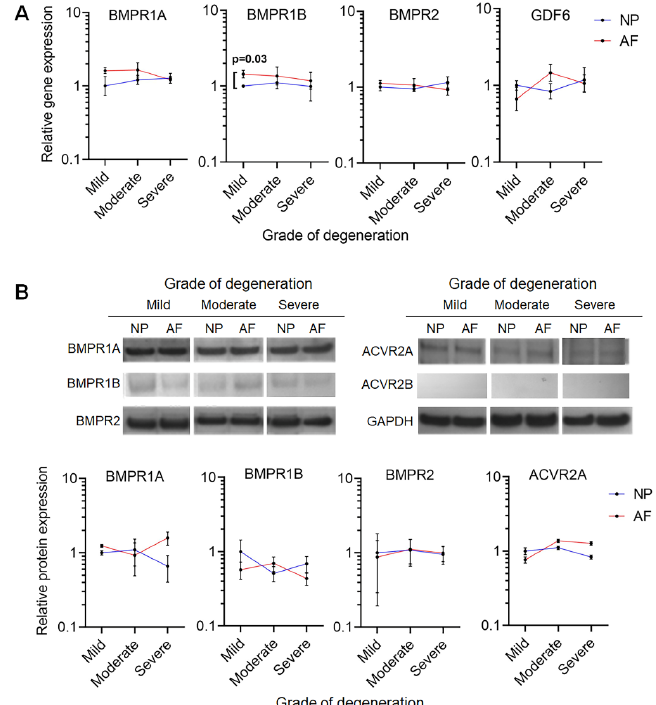
Figure 1. ( A ) Gene expression of GDF6 and associated receptors in nucleus pulposus (NP) and annulus fibrosus (AF) cells of different grades of degeneration relative to MRPL19 and normalised to NP cells of mild degeneration grade. Mild degeneration included grades 3–6, moderate degeneration included grades 7–9, and severe degeneration included grades 10–12, using our in-house grading scheme [33]. Gene expression is plotted as log10 of 2-ddCt, ( n = 24). Data are means ± SEM. Statistical significance was determined by Mann–Whitney U test between cell types at the same grading, and Brown–Forsythe and Welch ANOVA test for multiple testing between grades. ( B ) Western blot images and densitometric analysis comparing bone morphogenetic protein (BMP) receptor expression in NP and AF cells isolated from degenerate intervertebral discs (IVDs) ( n = 9 donor-matched NP and AF cells). Consistent receptor expression was observed between NP and AF tissue and between donors. Data are means ± SEM. Statistical significance was determined by Mann–Whitney